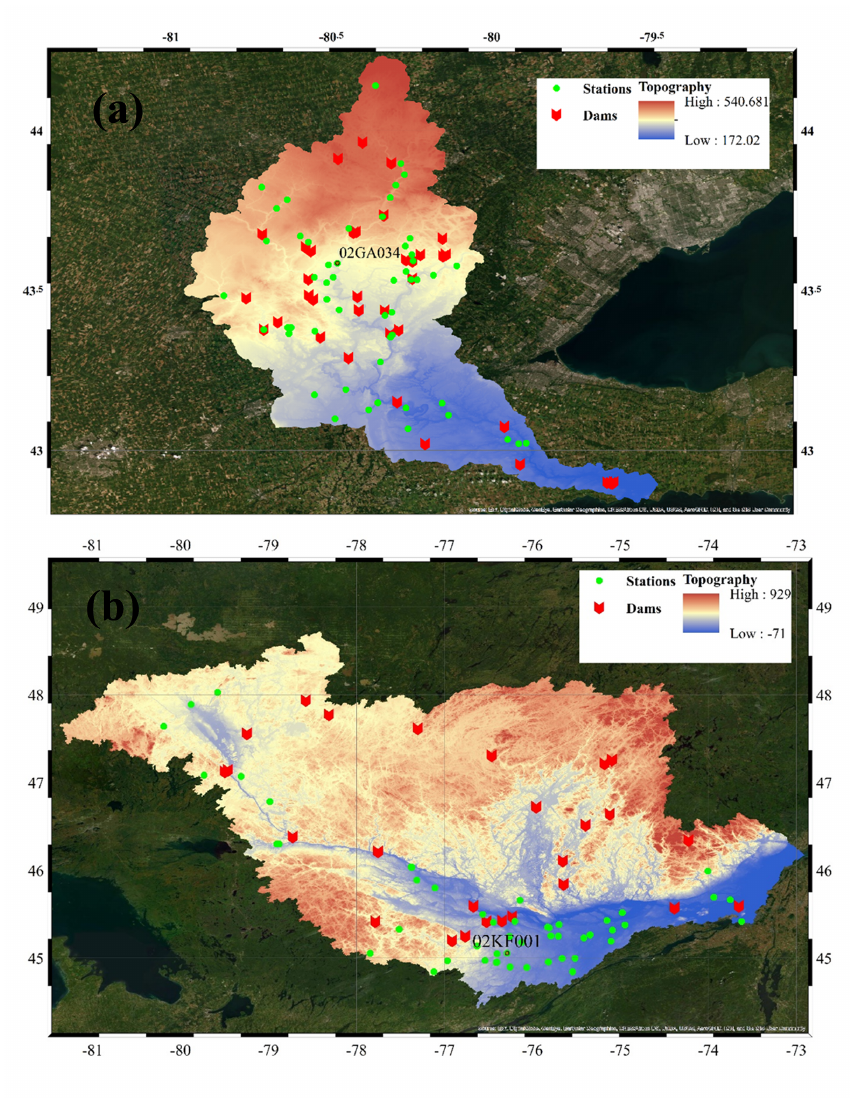
Figure 1. GIS input data – Grand River watershed (a) and Ottawa River watershed (b) topography. The maps are created in ArcGIS with the basemaps provided by © Esri. The stations that are used later in the Fig. 5 comparison are labeled in the